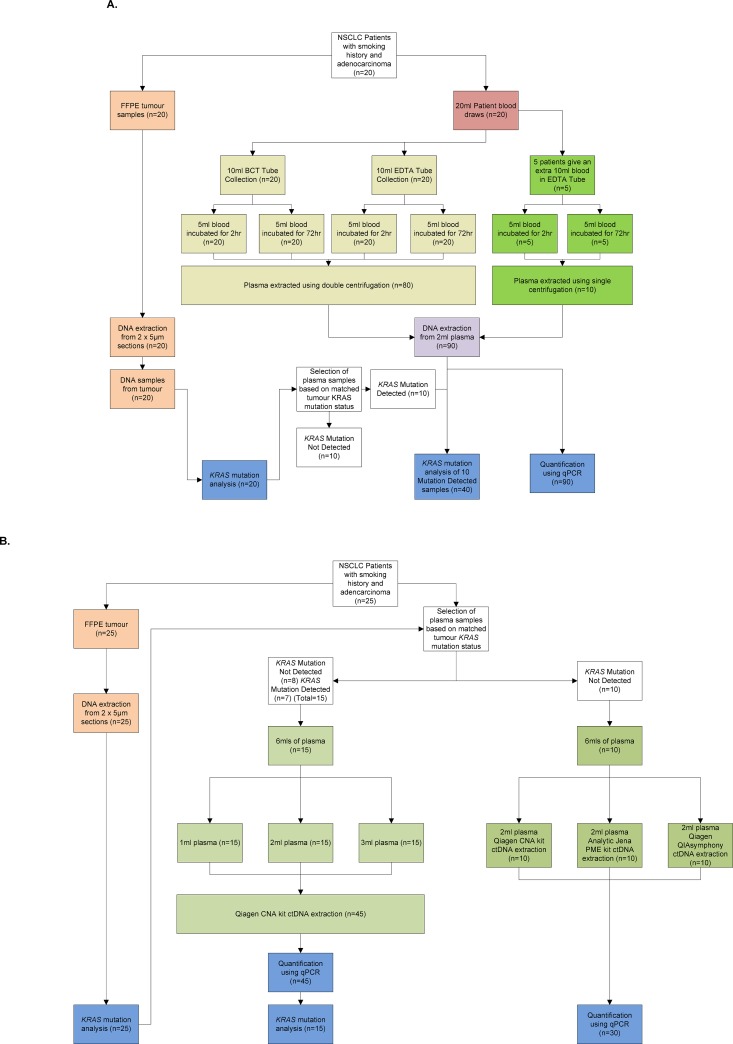
Sample workflow schematic.Diagram showing the experimental workflow for the different sample cohorts. Panel A. Comparison of Streck Cell Free (BCT) and EDTA tubes in addition to single and double centrifugation on DNA yield and mutation detection. B. Comparison of different plasma volumes and ctDNA extraction kits on DNA yield and mutation detection.